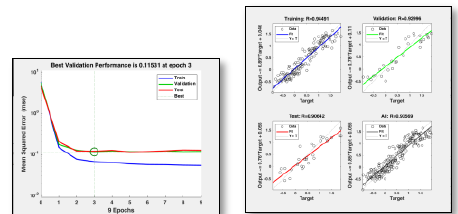
Figure 6. Performance curve, RMSE and R values of designed network for